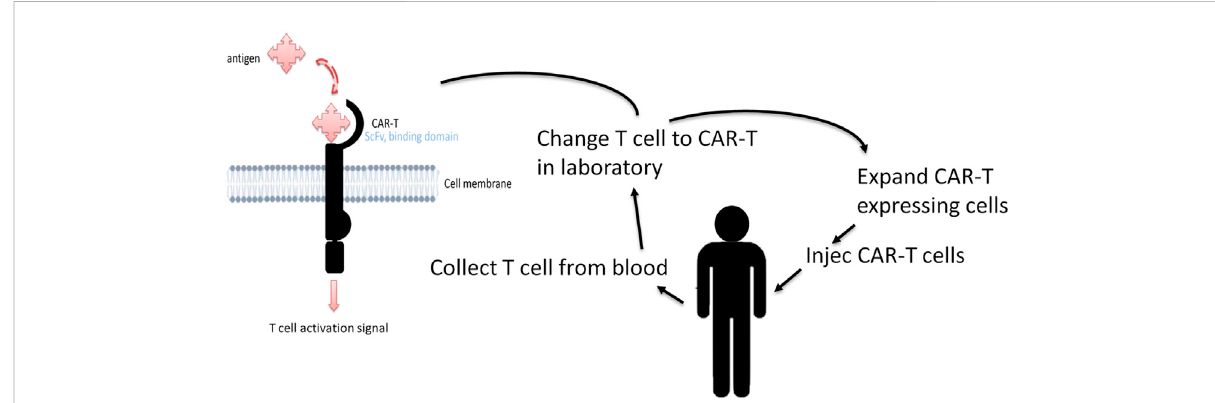
FIGURE 3 CAR-T structure and CAR-T cell therapy. The antigen-binding domain confers target speci fi city to CAR-T cells. This domain generally consists of variable heavy and light chains of monoclonal antibodies bound by a linker to form a single-chain variable fragment (scFv). The extracellular domain dictates the af fi nity and ef fi cacy of the CAR-T cells and is independent of MHC-mediated antigen presentation. The difference in the intracellular co-stimulatory domains results in the modulation of different pathways like T cell differentiation and type of cell death. CAR-T treatment works by redirecting a patient ’ s own immune T cells, engineered in the laboratory, to directly identify and attack cancer